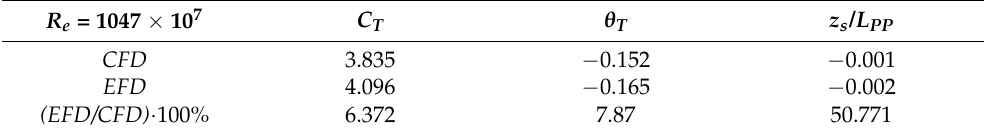
Table 8. Results of the calm water resistance for the KRISO